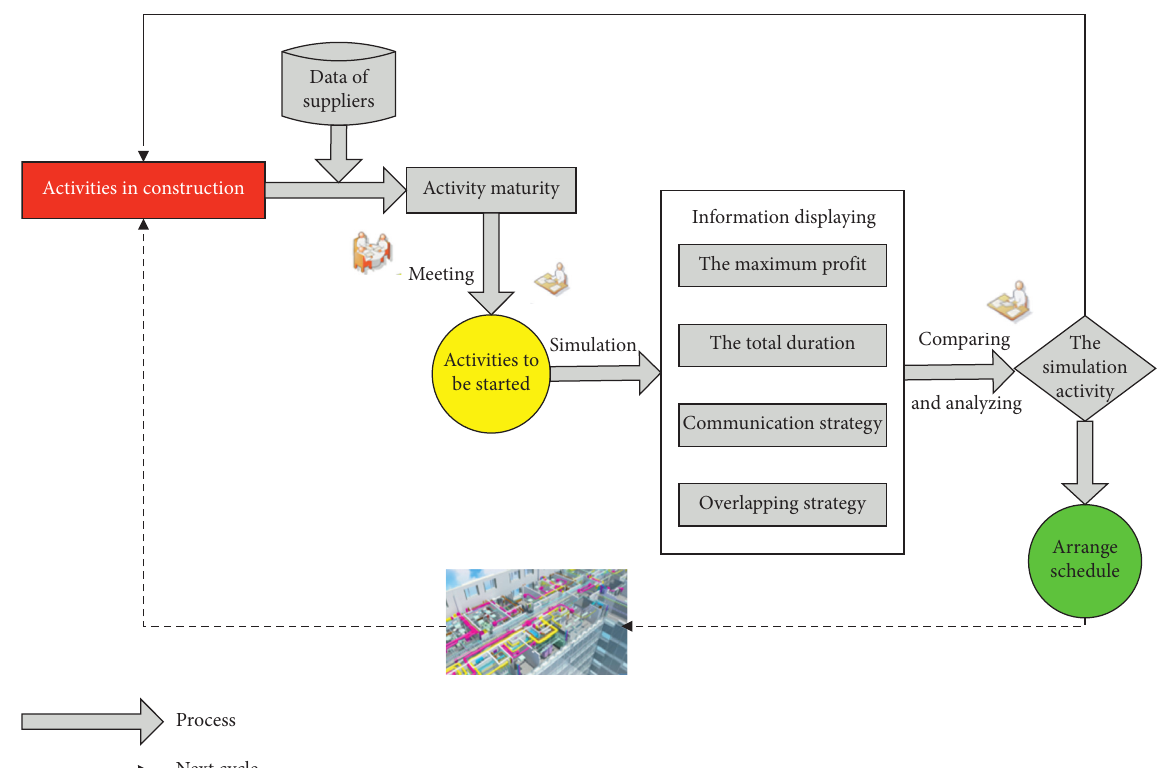
Figure 15: An intelligent control process for the development of